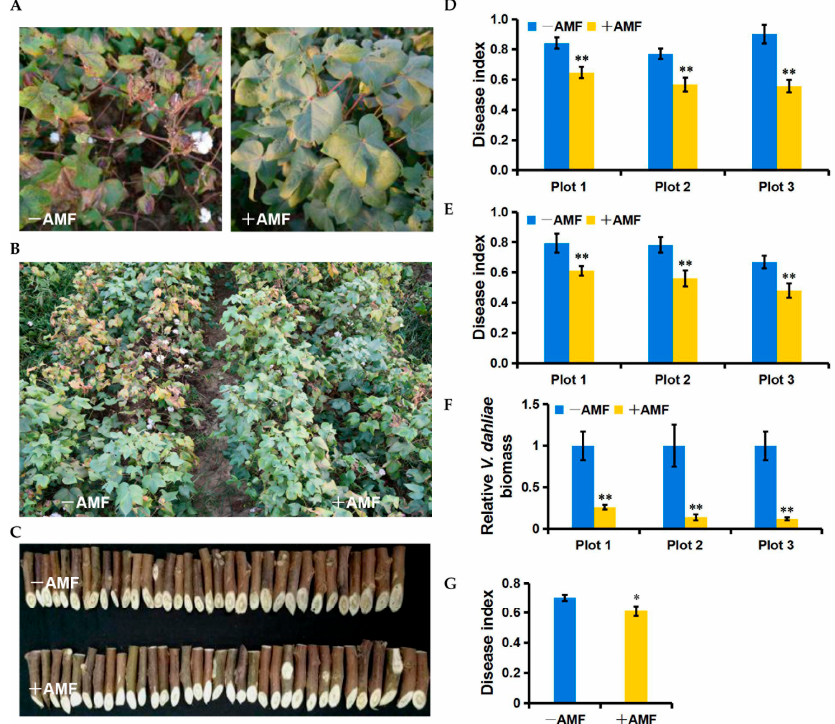
Figure 5. Effects of AMF on the Verticillium wilt resistance of Lumian 1 under field conditions. +AMF: mycorrhizal; − AMF: nonmycorrhizal. ( A ) The phenotypes of Lumian 1 at the early occurrence phase of Verticillium wilt; ( B ) The resistance phenotypes of Lumian 1 at 120 dpi in 2016; ( C ) The vascular discoloration phenotypes of Lumian 1 at 150 dpi in 2016; ( D , E ) The disease index of leaves at 120 dpi in 2015 ( D ) and 2016 ( E ), respectively. At least 40 plants were used for each experiment; ( F ) Quantitative detection of the V. dahliae biomass relative to cotton leaves at 120 dpi in 2016. The average fungal biomass was determined using at least 10 mycorrhiza-treated and 10 control cottons of each plot; ( G ) The disease index of the vascular bundle at 150 dpi in 2016. Error bars represent ± SD. * p < 0.05; ** p < 0.01.